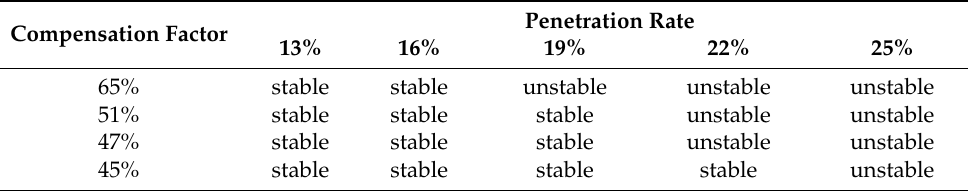
Table 4. Stability for various compensation factors and rating factors.